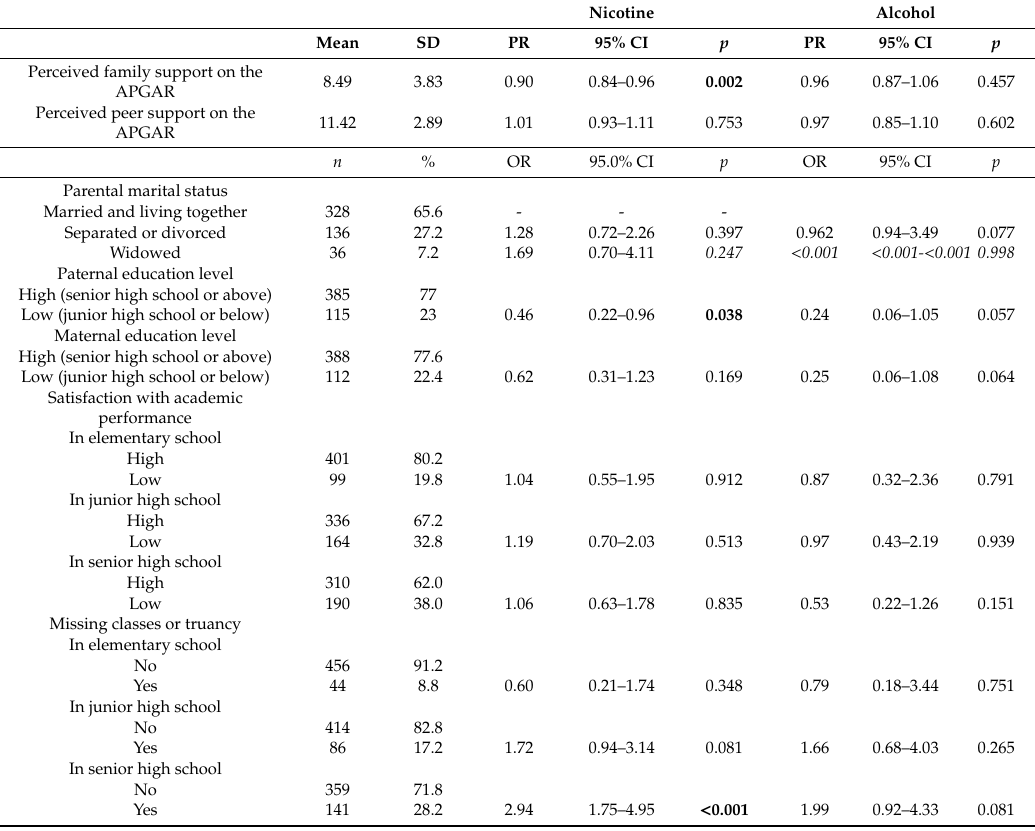
Table 5. Family, peer and school factors associated with nicotine and unhealthy alcohol use examined by univariate logistic regression ( n =